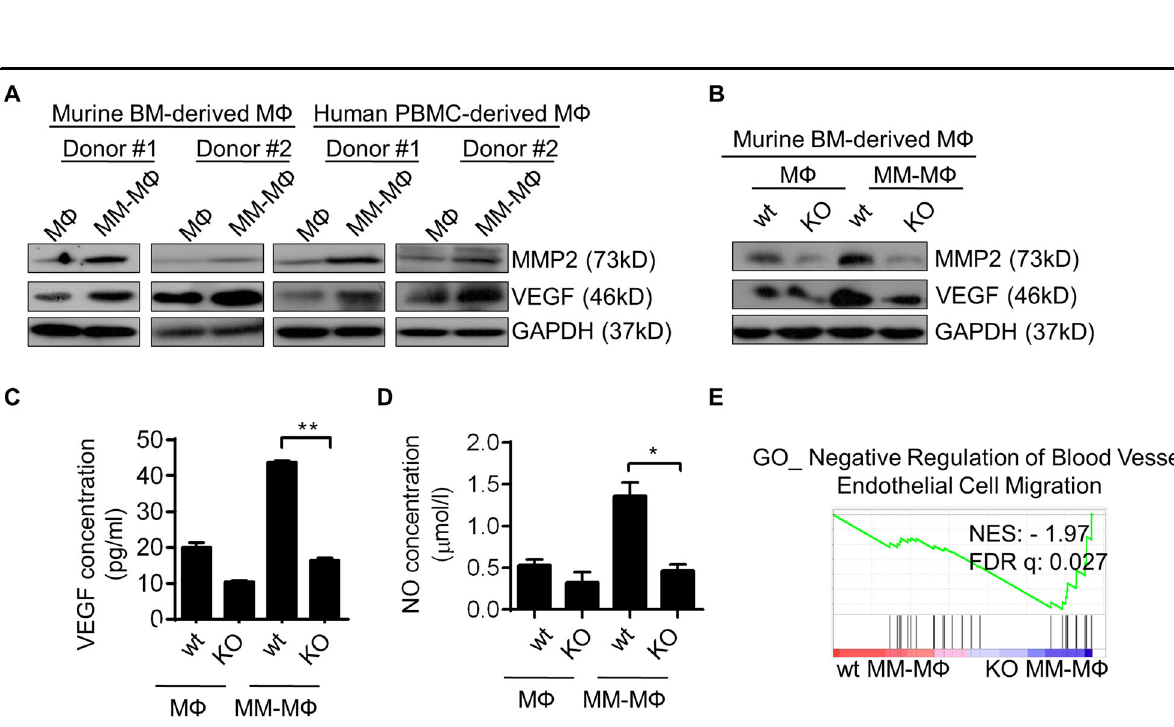
with BMI1-KO M Φ s (Fig. 6C), suggesting that BMI1-KO